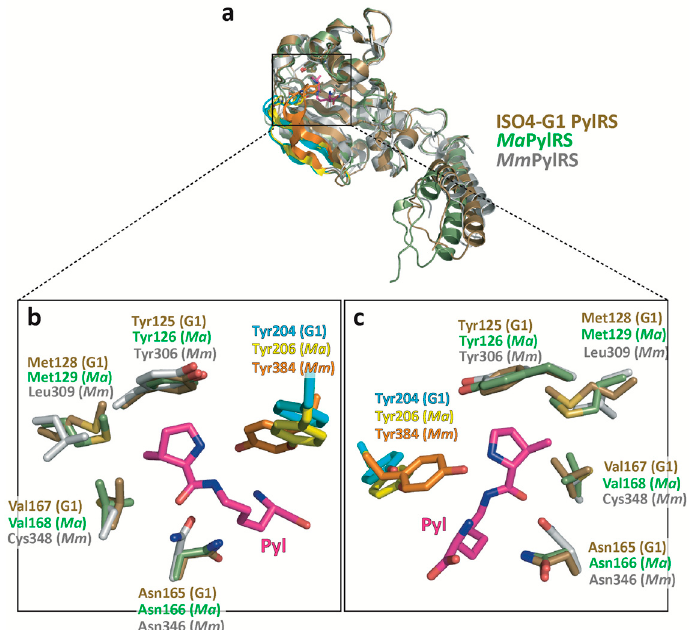
Figure 3. Comparison of the amino acid binding pocket of ISO4-G1 PylRS with those of Ma PylRS and Mm PylRSc. ( a ) Ribbon models of ISO4-G1 PylRS molecule B (brown) superimposed on the Ma PylRS (light green) and Mm PylRSc (gray) monomers. ( b , c ) Close-up views of different angles of the ISO4-G1 PylRS active site. The active site residues in the ISO4-G1 PylRS apo form (brown) are superimposed on those of Ma PylRS (light green) and Pyl-AMP-bound Mm PylRSc (gray). Along with pyrrolysine (Pyl), the active site residues in ISO4-G1 PylRS (Tyr125, Met128, Asn164, Val166, and Tyr204), Ma PylRS (Tyr126, Met129, Asn166, Val168, and Tyr206), and Mm PylRSc (Tyr306, Leu309, Asn346, and Cys348) are represented as stick models. The β 5- β 6 and Tyr204 in ISO4-G1 PylRS, the β 5- β 6 and Tyr206 in Ma PylRS, and the β 7- β 8 and Tyr384 in Mm PylRSc are highlighted in cyan, yellow, and orange, respectively.